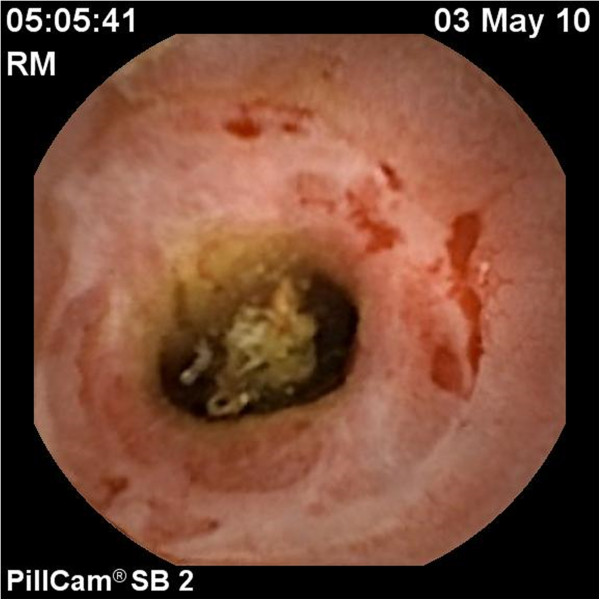
Capsule endoscopy showing extensive enteritis of the jejunum.